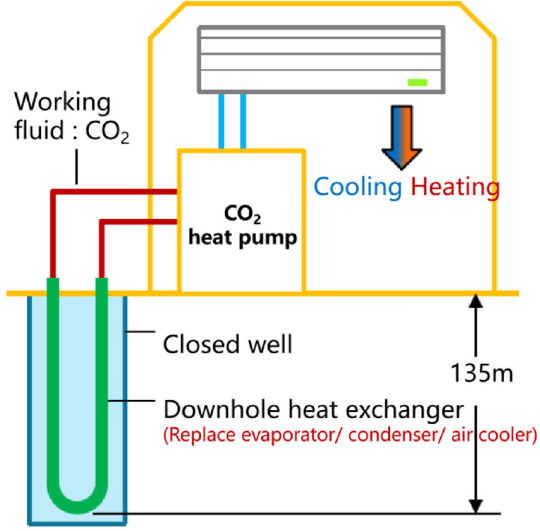
Fig. 23 Direct expansion CO 2 heat pump